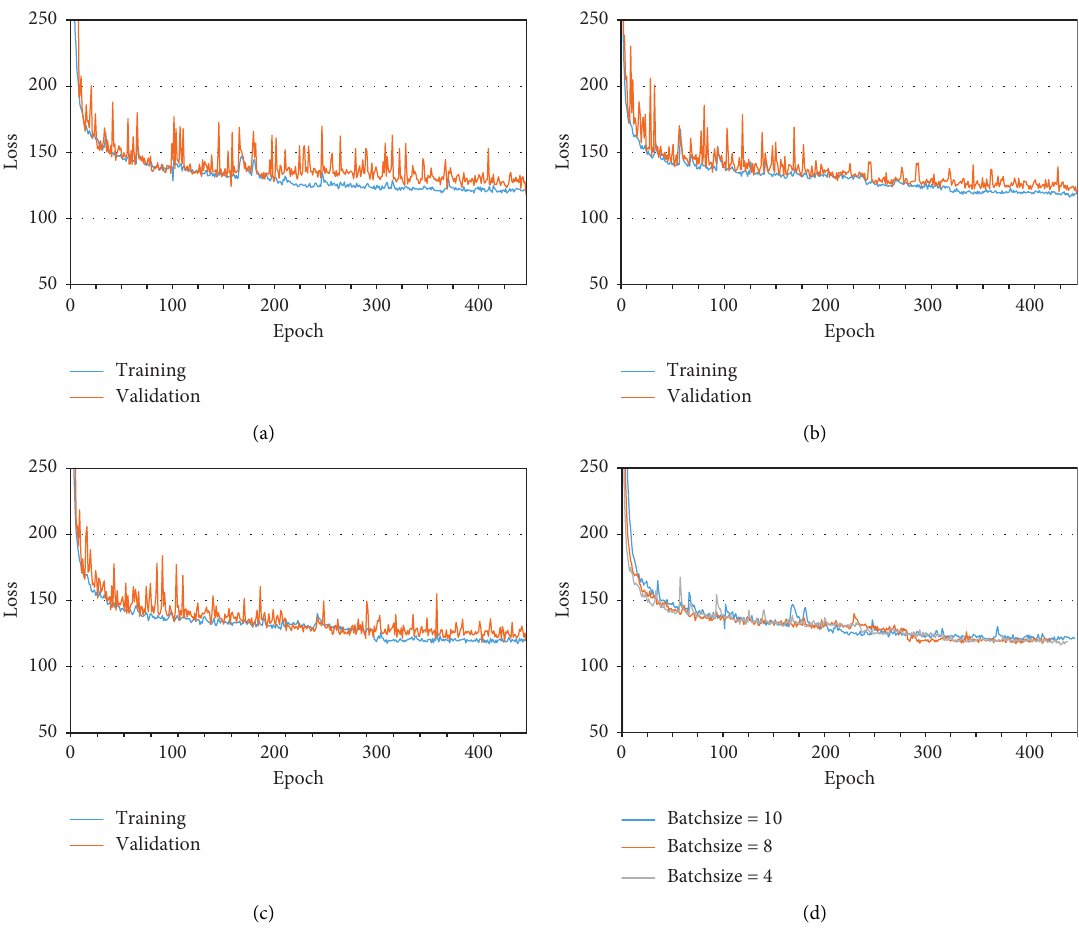
Figure 4: The losses during the training with dataset T4. (a) When batch size � 10; (b) when batch size � 8; (c) when batch size � 4; (d) the comparisons of training losses between different batch sizes. Table 2: The statistics when detecting the 4 typical samples by our model. T1 T2 T3 T4 (a) The results of Figure